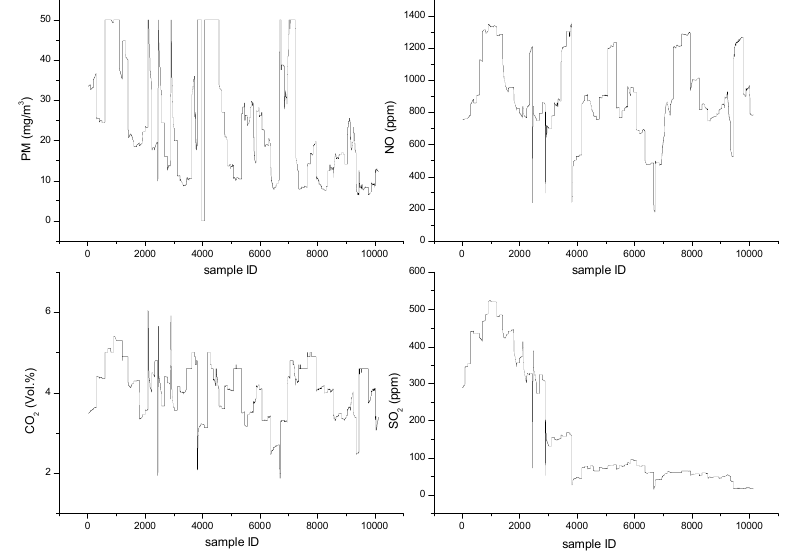
Figure 3. Changes in various gas concentrations.